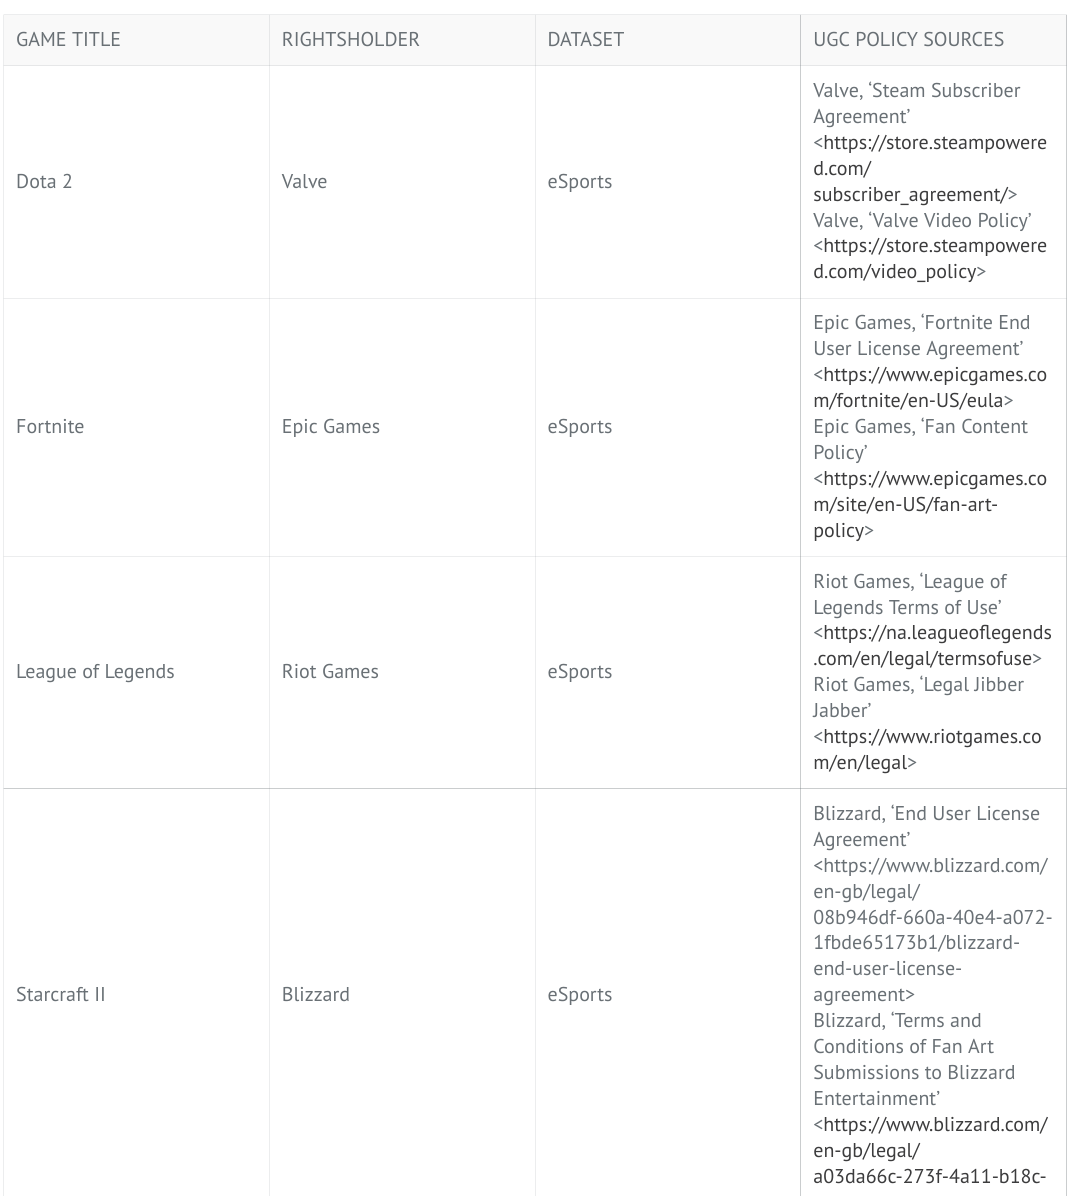
TABLE 2: Dataset of game titles and UGC